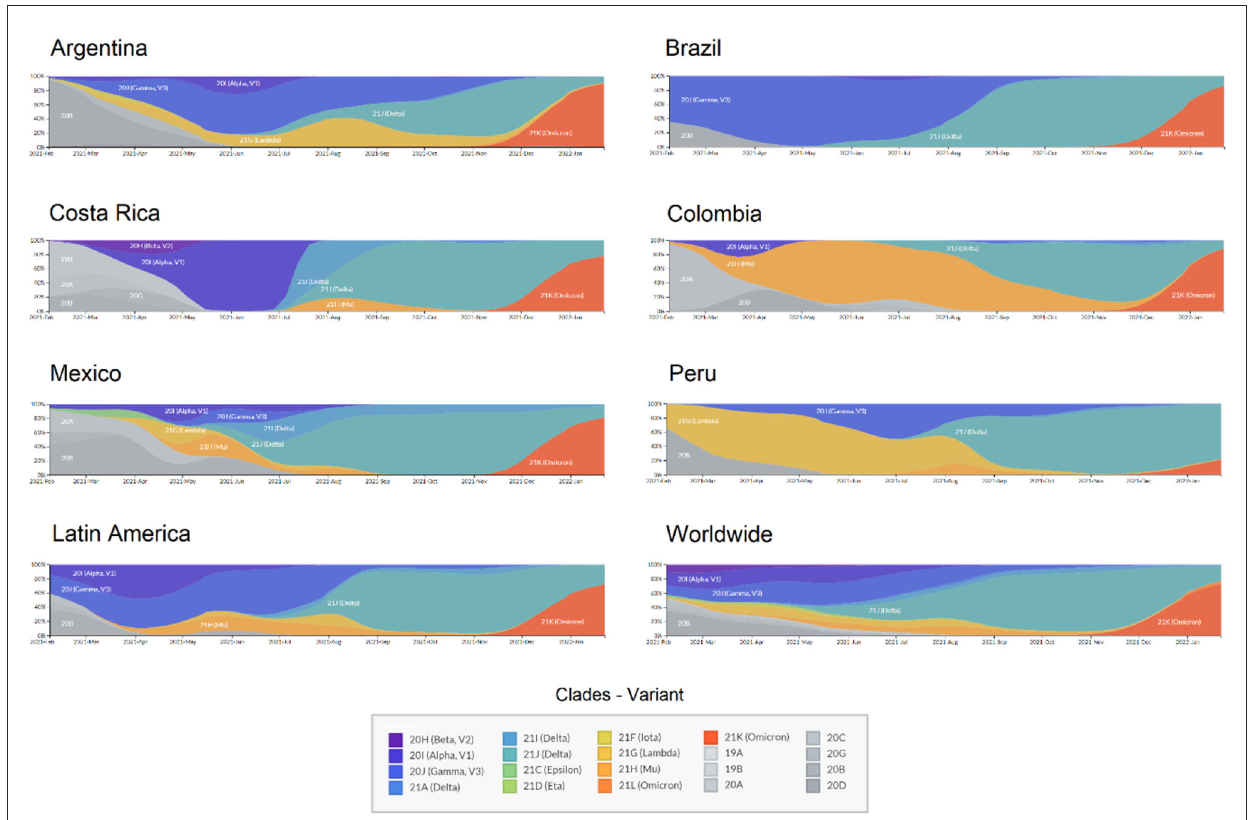
FIGURE2 Transition of SARS-CoV-2 variants circulating in six Latin American countries and worldwide during 2021. X: time from February 2021 to January 2022; Y: Relative abundance of SARS-CoV-2 genotypes.